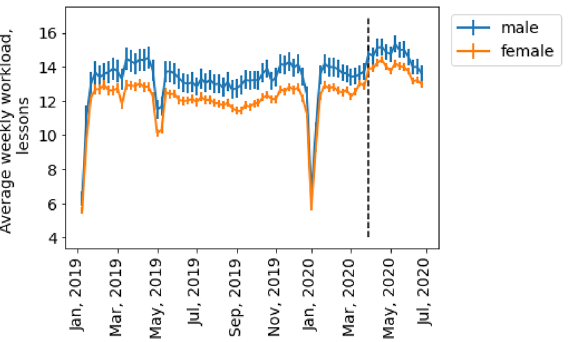
Figure 1. Average weekly teaching workload over 78 weeks, from January 1, 2019, to July 1, 2020. Vertical bars correspond to 95% confidence intervals. The black dashed line indicates the start of the national lockdown. The male teachers had a higher workload than the female teachers at Skyeng. Workload decreased in January and May (New Year and Christmas and national holidays,